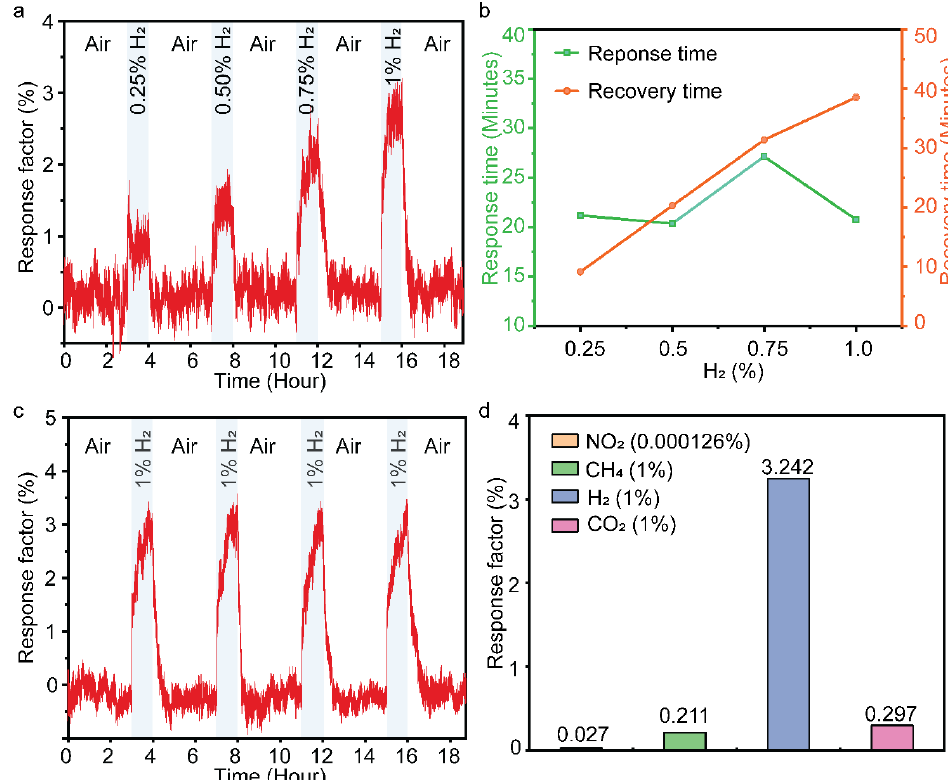
Figure 4. Gas sensing response for nickel oxysulfide at room temperature in the balance of air, ( a ) dynamic response toward H 2 , ( b ) the corresponding response/recovery time. ( c ) repeatability and ( d ) selectivity.